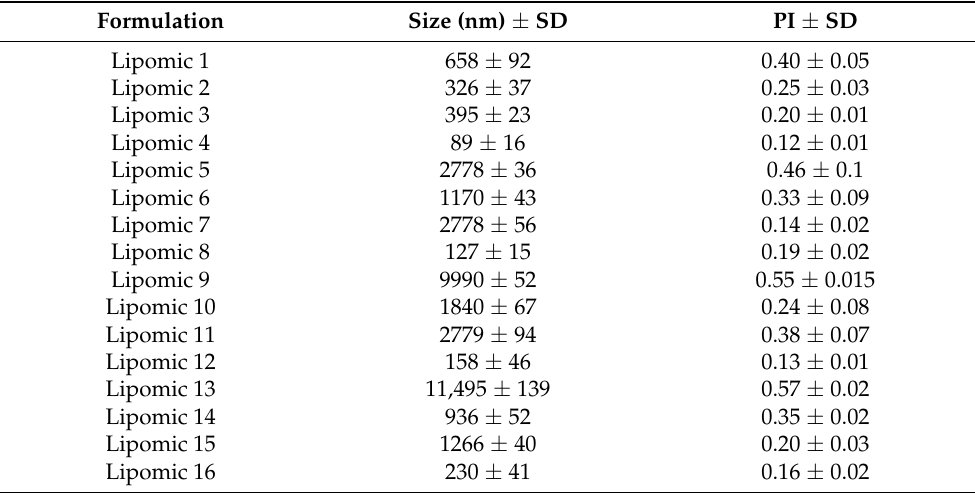
Table 1. Hydrodynamic diameter size and polydispersity index for lipomics from each formulation. Values represent the average and standard deviation of three independent